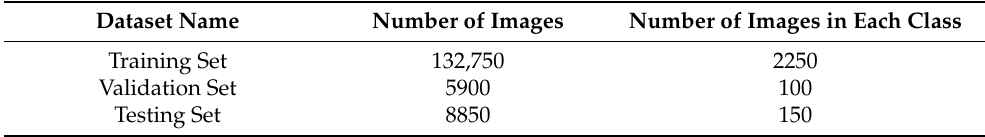
Table 3. Training, validation and test dataset